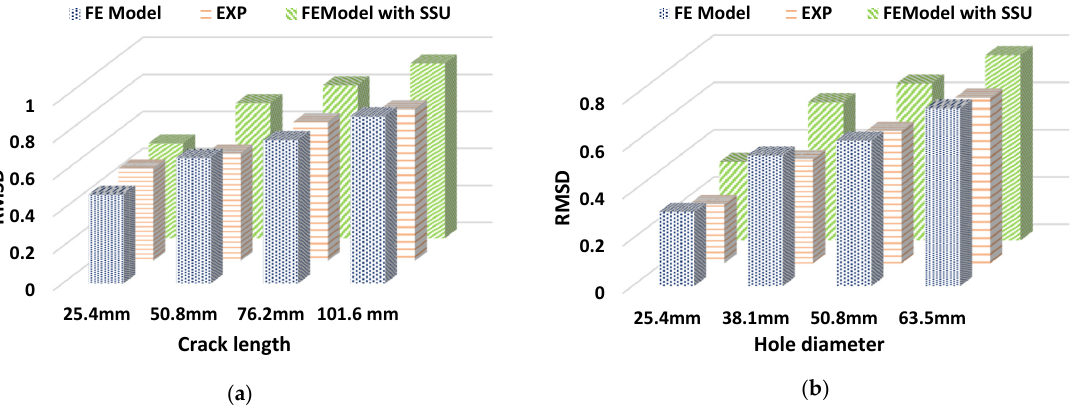
Figure 26. RMSD comparison plot between numerical simulation of existing smart aggregate, experimental results, and numerical simulation with SSU: ( a ) for a beam with crack; ( b ) for a beam with hole.